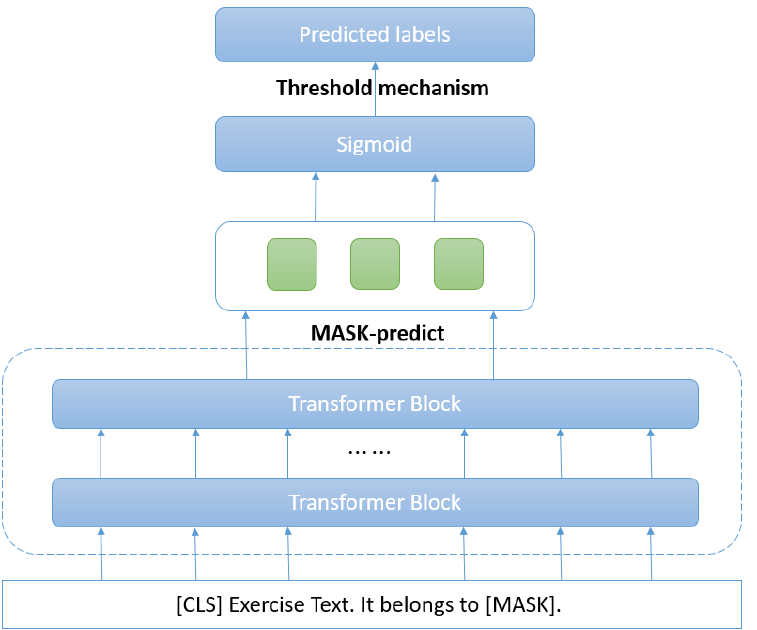
Figure 2. The general framework of our PTMLTC. Exercise Text sequence is connected with united template as the input of prefix Language Model. It will then predict the probability of filling the token [MASK] with each word of knowledge concepts. Sigmoid () function is used to obtain the probability of exercise texts linking to knowledge concept labels. Finally, a threshold mechanism is adopted to predict all the possible knowledge concept